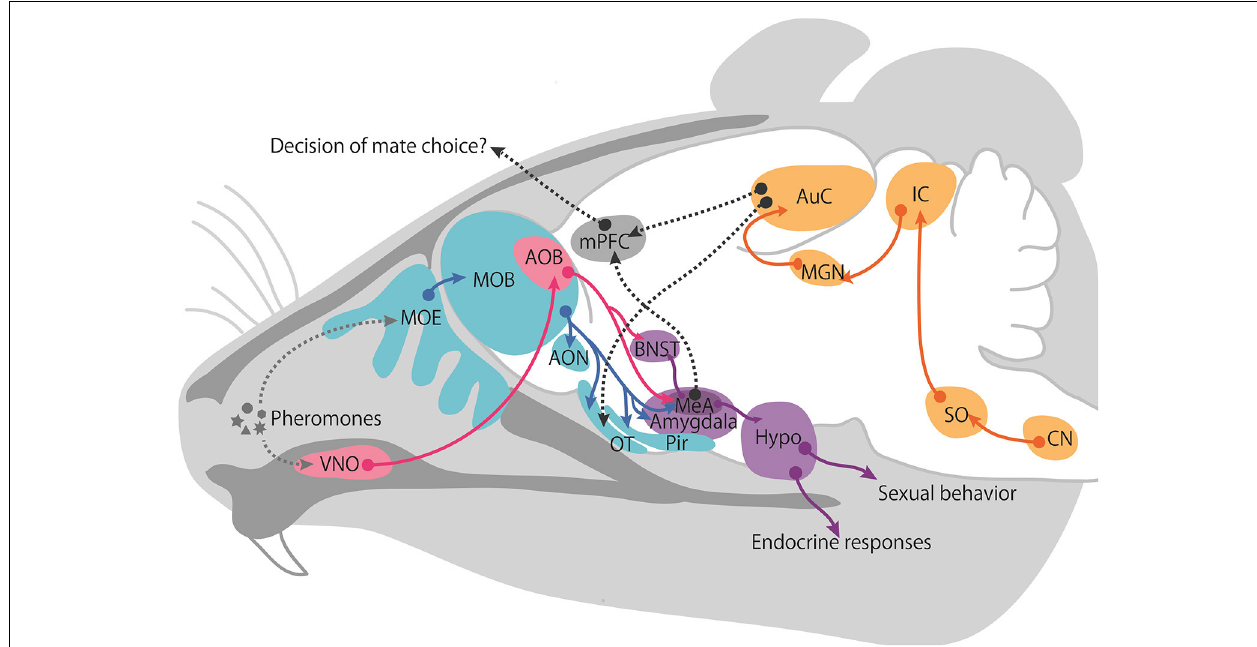
FIGURE 2 | Proposed schematic of female neural pathways for male chemical and vocalization signals. The vomeronasal pathway is shown in pink, main olfactory pathway in blue, intracortical projection in purple, auditory pathway in yellow, and the hypothetical integrate pathway is represented with a gray dotted line. Abbreviations: accessory olfactory bulb (AOB), anterior olfactory nucleus (AON), auditory cortex (AuC), bed